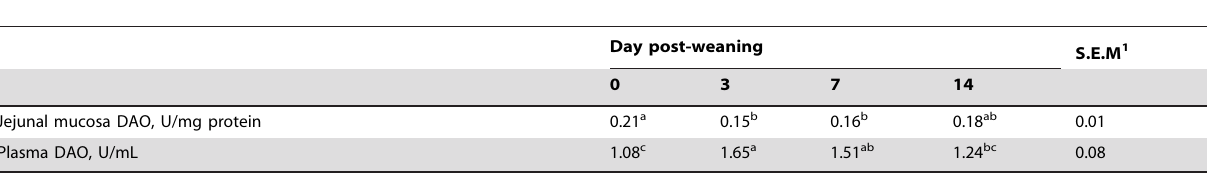
Table 3. Diamine oxidase (DAO) in plasa and mucosa of weaned pigs.